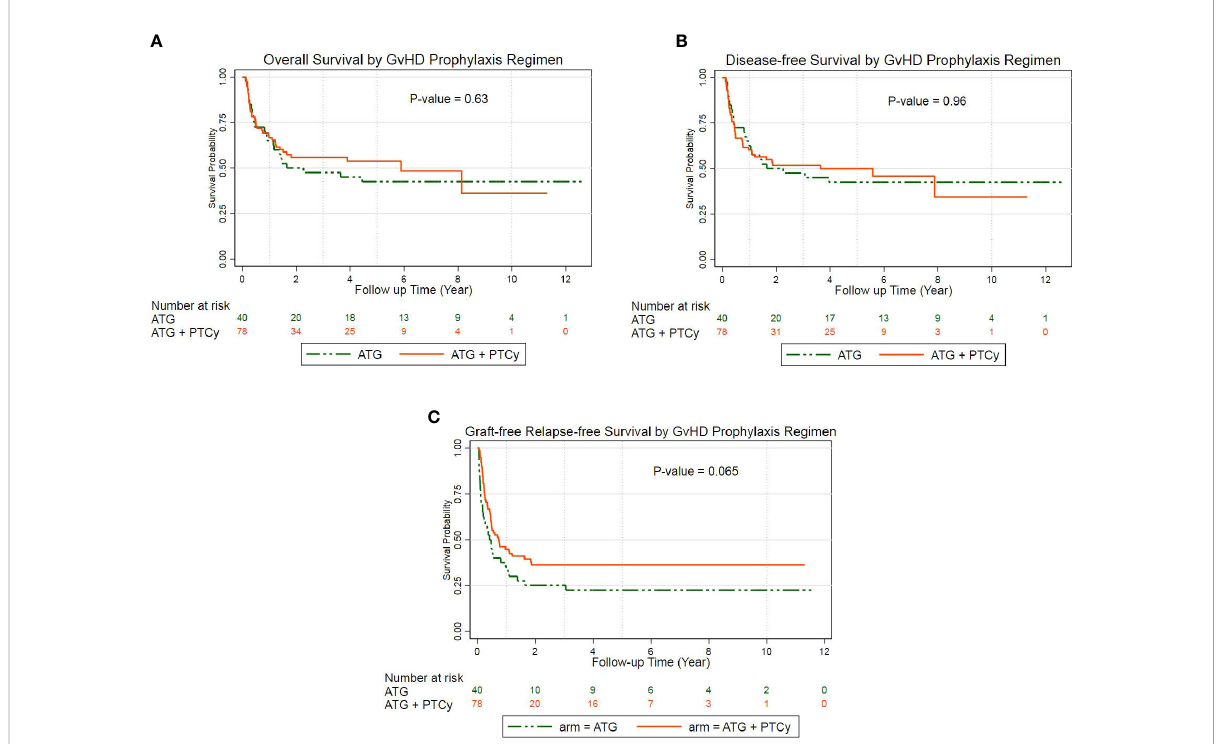
FIGURE 2 Probability of survival according to treatment groups: (A) Kaplan – Meier estimates of overall survival; (B) Kaplan – Meier estimates of disease-free survival; (C) Kaplan – Meier estimates of GvHD-free, relapse-free